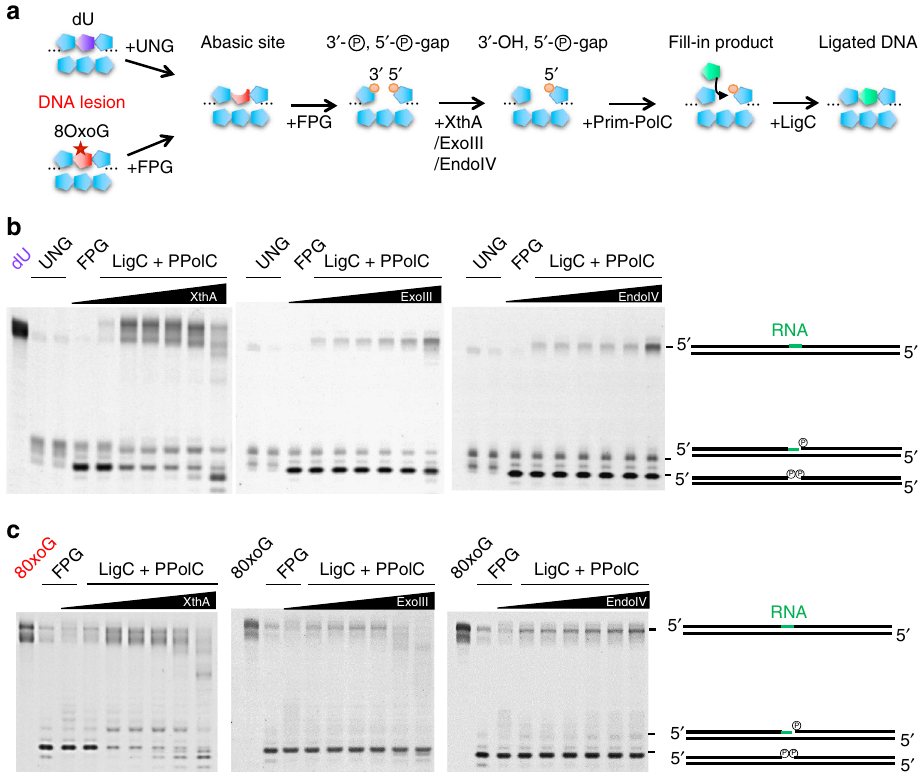
Fig. 4 Reconstitution of a Prim-PolC - LigC1-dependent BER repair complex in vitro. a Schematic representation of BER repair reactions showing repair intermediates generated by subsequent DNA repair activities of glycosylases, end-processing enzymes, gap- fi lling and ligation. b , c In vitro repair of deoxyuracil- b or 8-oxoguanine- c containing DNA substrates. 30 nM of 5 ′ - fl uorescein labelled ds 36-mer containing a central lesion was processed by uracil glycosylase or directly by recombinant mycobacterial FPG (for 8-oxoguanine), to produce a resulting abasic site intermediate processed into a 3 ′ ,5 ′ - biphosphorylated gap by the abasic site lyase activity of FPG. Reactions were carried out with addition of a 250 µ M dNTPs or rNTPs mix for 30 min at 37 ° C. Gap ends were next processed, including removal of the 3 ′ phosphate, by addition of various amounts of either XthA, ExoIII or EndoIV for 5 min at 37 °C. Subsequently, a mixture of Prim-PolC and LigC1, 300 nM of each, was added to provide gap fi lling and ligation activities for 45 min at 37